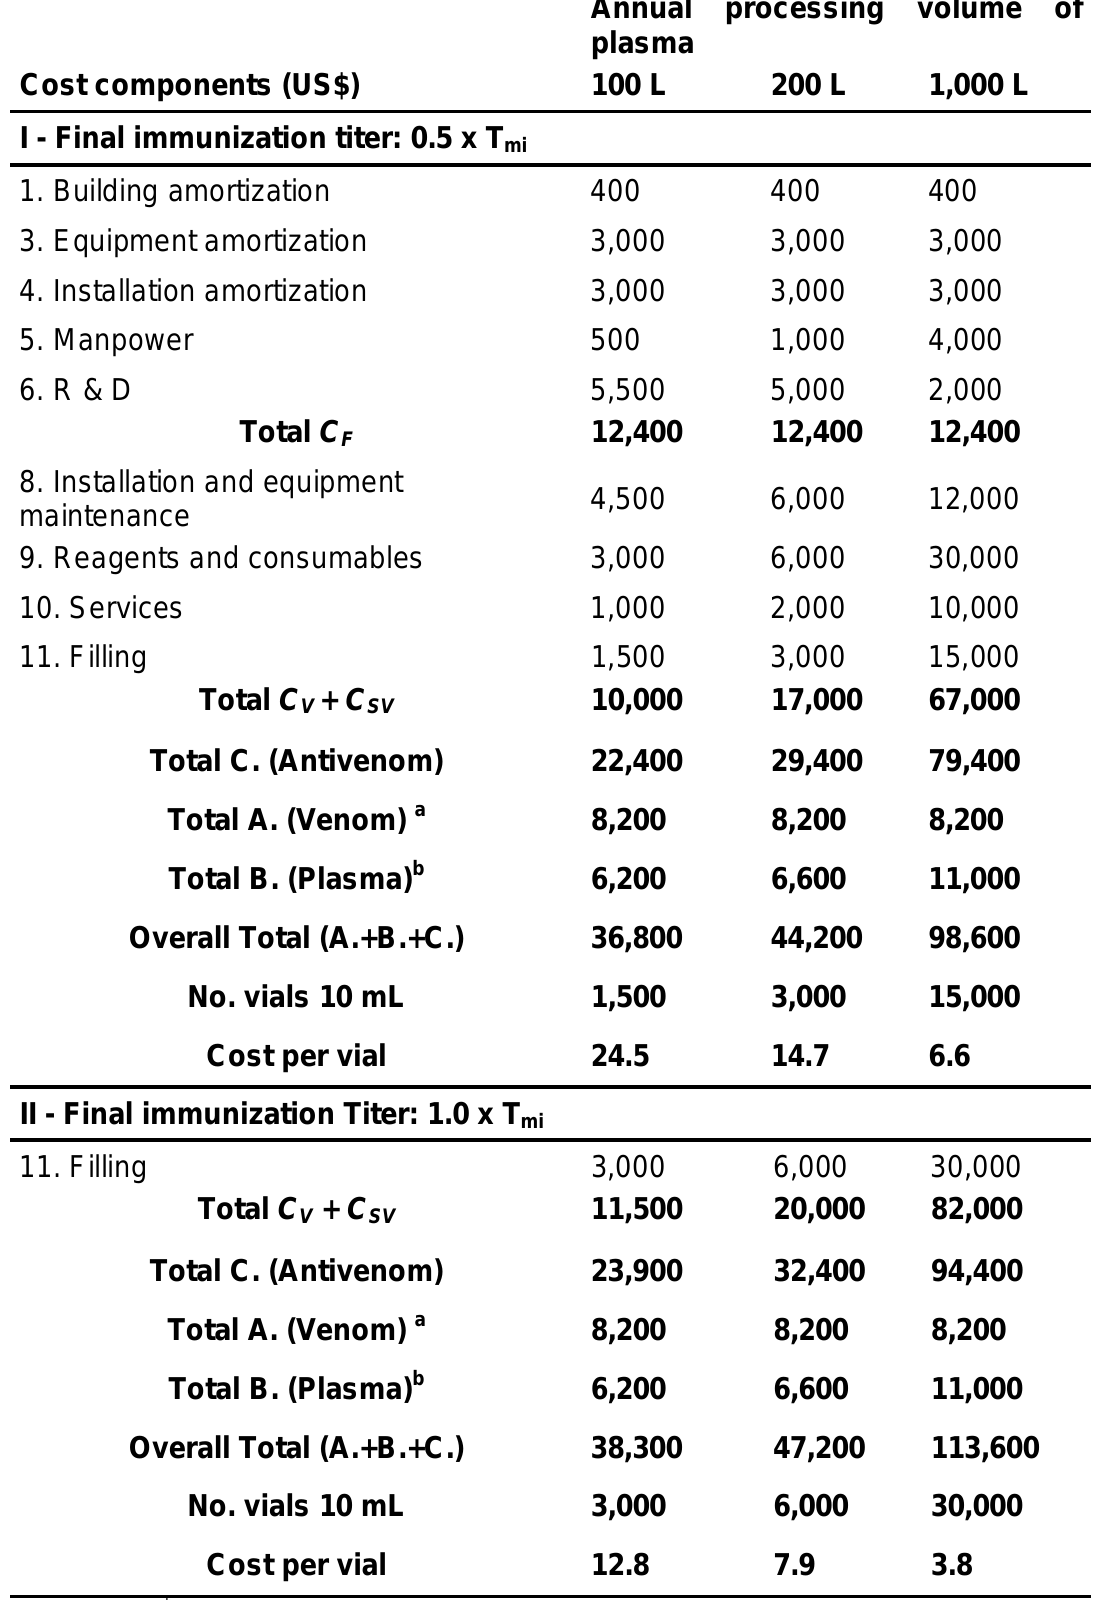
Table 4: Costs associated to the third stage of snake antivenom production: C. Antivenom production; total cost and unitary cost. Overall process activity yield as F(ab’) : 2